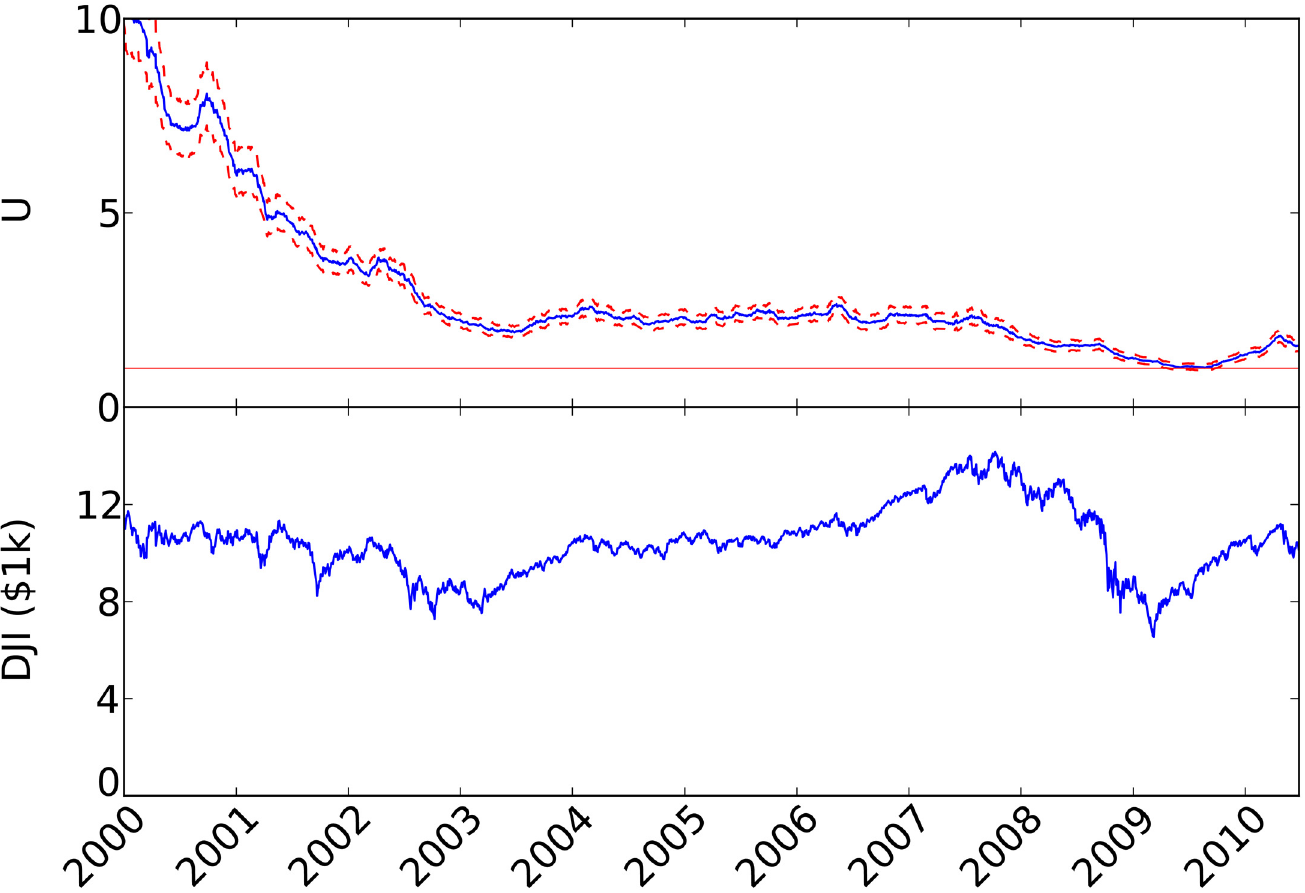
Fig 2. Model parameter (top panel) and the Dow Jones Industrial Average (bottom panel) for the period 2000 – 2010. Estimates of the model parameter are shown at the end of the year-long period for which U was estimated. Sampling error estimates are drawn at ± 1 standard deviations. Positive-return distributions are computed from the daily returns of stocks of the Russell